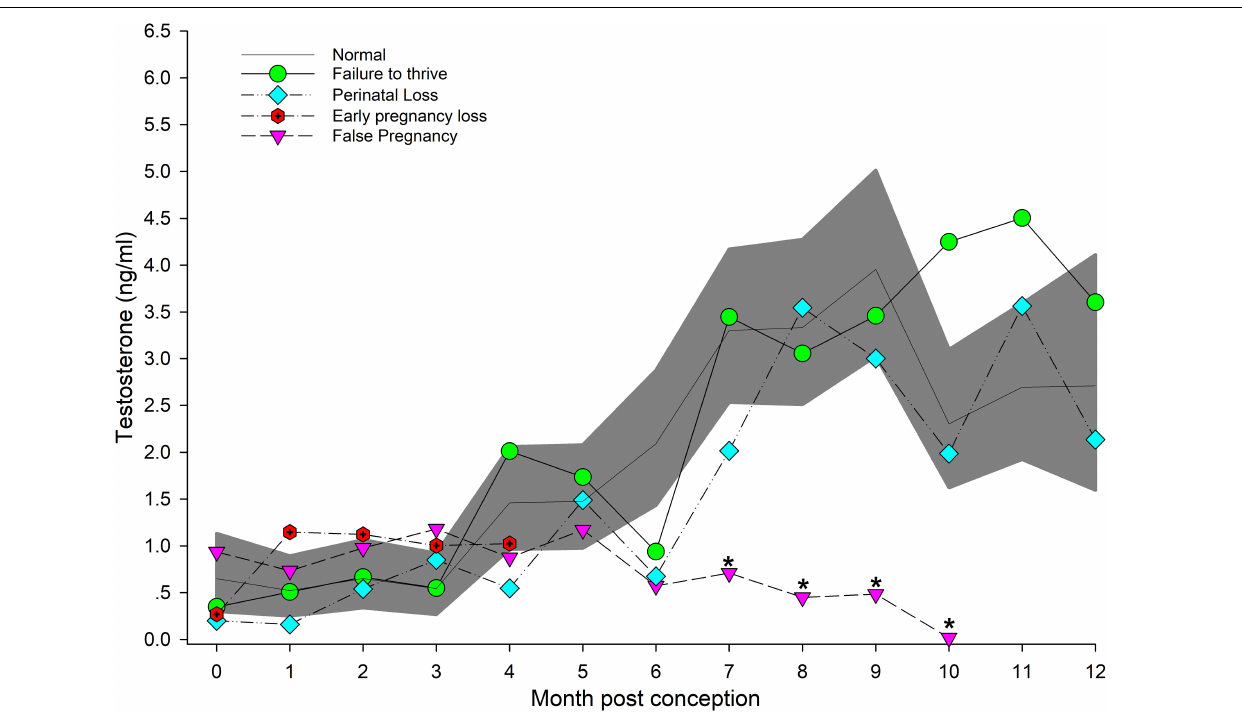
FIGURE 1 | The marginal predicted 95% CI for testosterone during each month post-conception (MPC) of normal pregnancies as represented by the dark gray shaded portion of the graph and the mean by a solid black line. Line graphs with data points represent each abnormal pregnancy (marginal mean). MPC of abnormal pregnancies (or month post ovulation for false pregnancies) that have mean concentrations that are significantly different from normal are highlighted with an asterisk (*). Data were square root transformed for analysis and then back-transformed for data presentation.